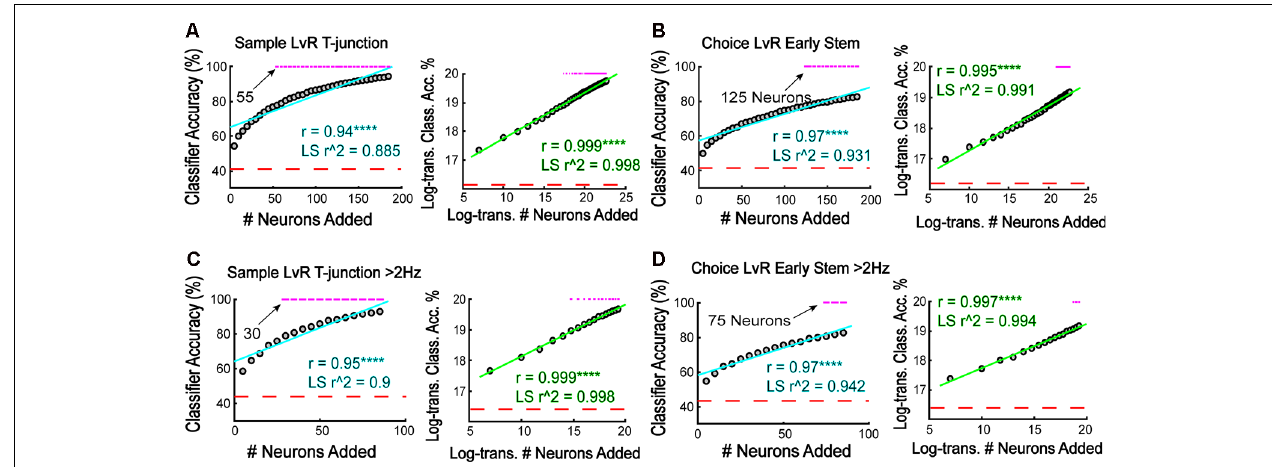
FIGURE 7 | More neurons are required to predict a future choice than are required to reflect a forced behavior. (A) The classifier was iteratively trained/tested to predict whether rats were on the left or right trajectory at sample phase T-junction. Notice that 55 neurons were required to achieve above-chance prediction. Additionally, there is a strong positive correlation between classifier accuracy and the number of added neurons ( r = 0.94, **** p = 3.2e-18), with the relationship being linear following log-transformation ( r = 0.999, **** p = 4.3e-47). Linear regression modeling revealed lower residual error and greater prediction with log-transformed data (non-transformed data SSE = 448.2, r 2 = 0.885; log-transformed data SSE = 0.03 r 2 = 0.997). Each gray dot indicates the grand mean classification average over 5,000 shuffles of N (sample size) neurons. (B) The classifier was trained to predict choice phase left vs. right during early stem runs (second stem bin). Notice that 125 neurons were required to approach above chance accuracy. Additionally, the relationship between classifier accuracy and the number of neurons added was linear following a log-transformation ( r = 0.97, **** p = 3.3e-22 not-transformed data; r = 0.995, **** p = 3.6e-37 log-transformed data; Pearson’s correlation). Linear regression modeling revealed lower residual error and greater prediction with log-transformed data (non-transformed SSE = 177, r 2 = 0.931; log-transformed SSE = 0.102, r 2 = 0.991). (C) High-rate neurons were trained to predict left vs. right trajectory at sample phase T-junction similar to (A,B) . Log-transformed data have higher linear correlation (non-transformed r = 0.953, **** p = 3.4e-09; log-transformed data r = 0.999, **** p = 2.1e-21). A linear regression revealed that log-transformed data have lower residual error and greater predictability (non-transformed data SSE = 153.2, r 2 = 0.9; log-transformed data SSE = 0.012, r 2 = 0.998). (D) High-rate neurons were trained to predict left vs. right trajectory during choice phase early stem traversal (second stem bin) with increasing number of added neurons to the classifier. Log-transformed data have a higher linear correlation (non-transformed r = 0.972, **** p =